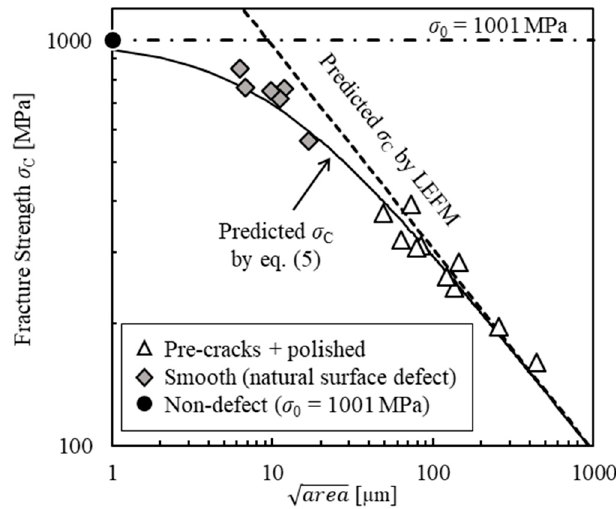
√ area of Al 2 O 3 /SiC